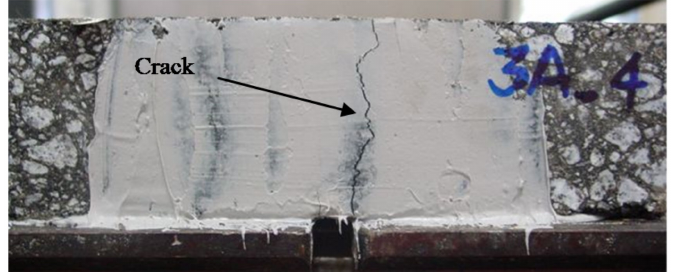
Figure 9. Reflective crack example produced on the sample after the test (side